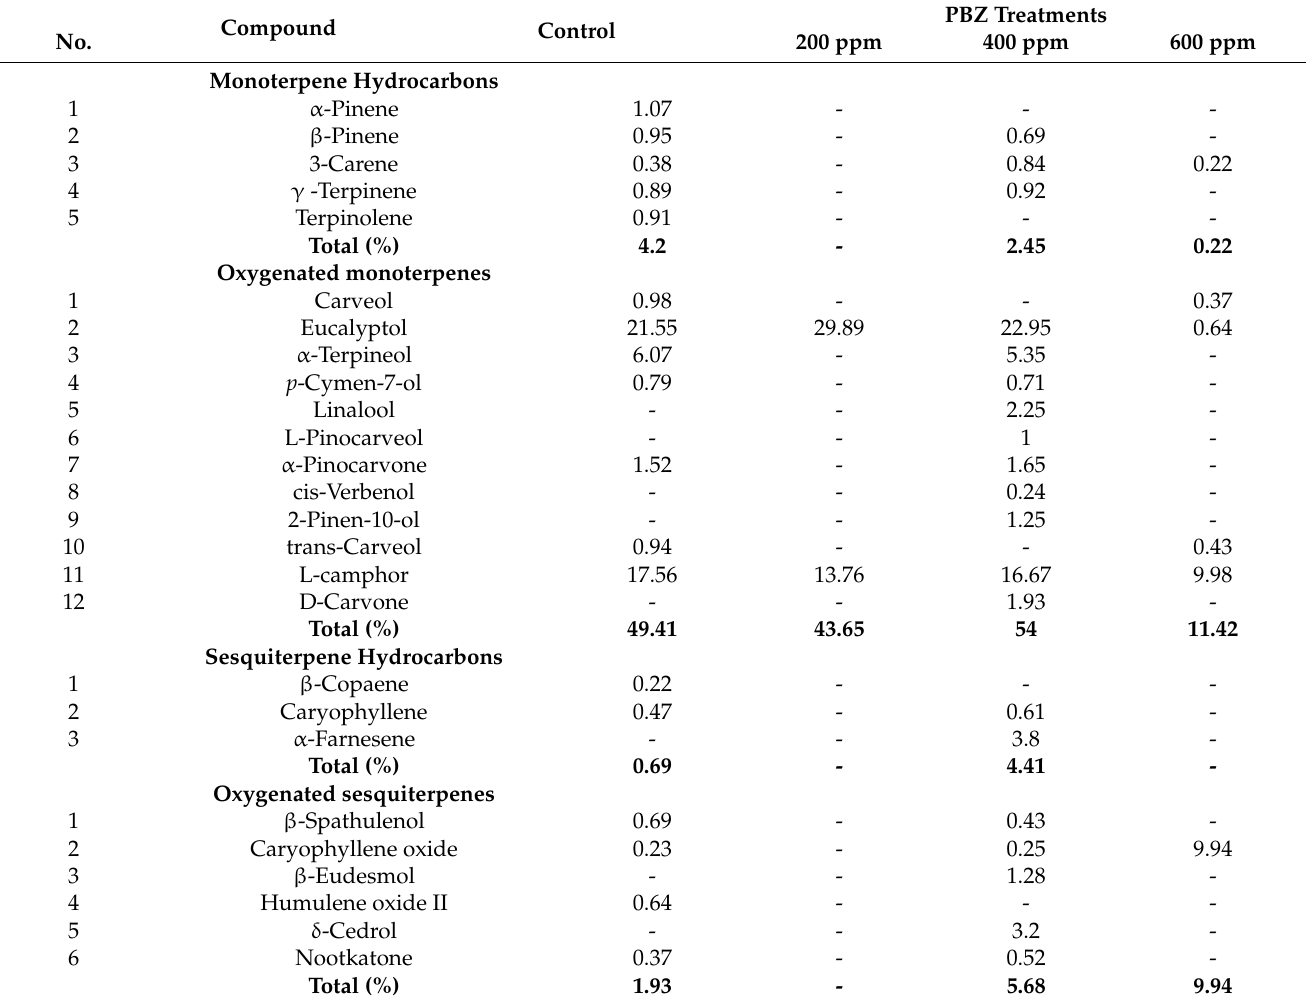
Table 1. Quantity of monoterpene and sesquiterpene constituents of the lavender essential oil (%), identified by GC-MS analysis of untreated with paclobutrazole lavender plants